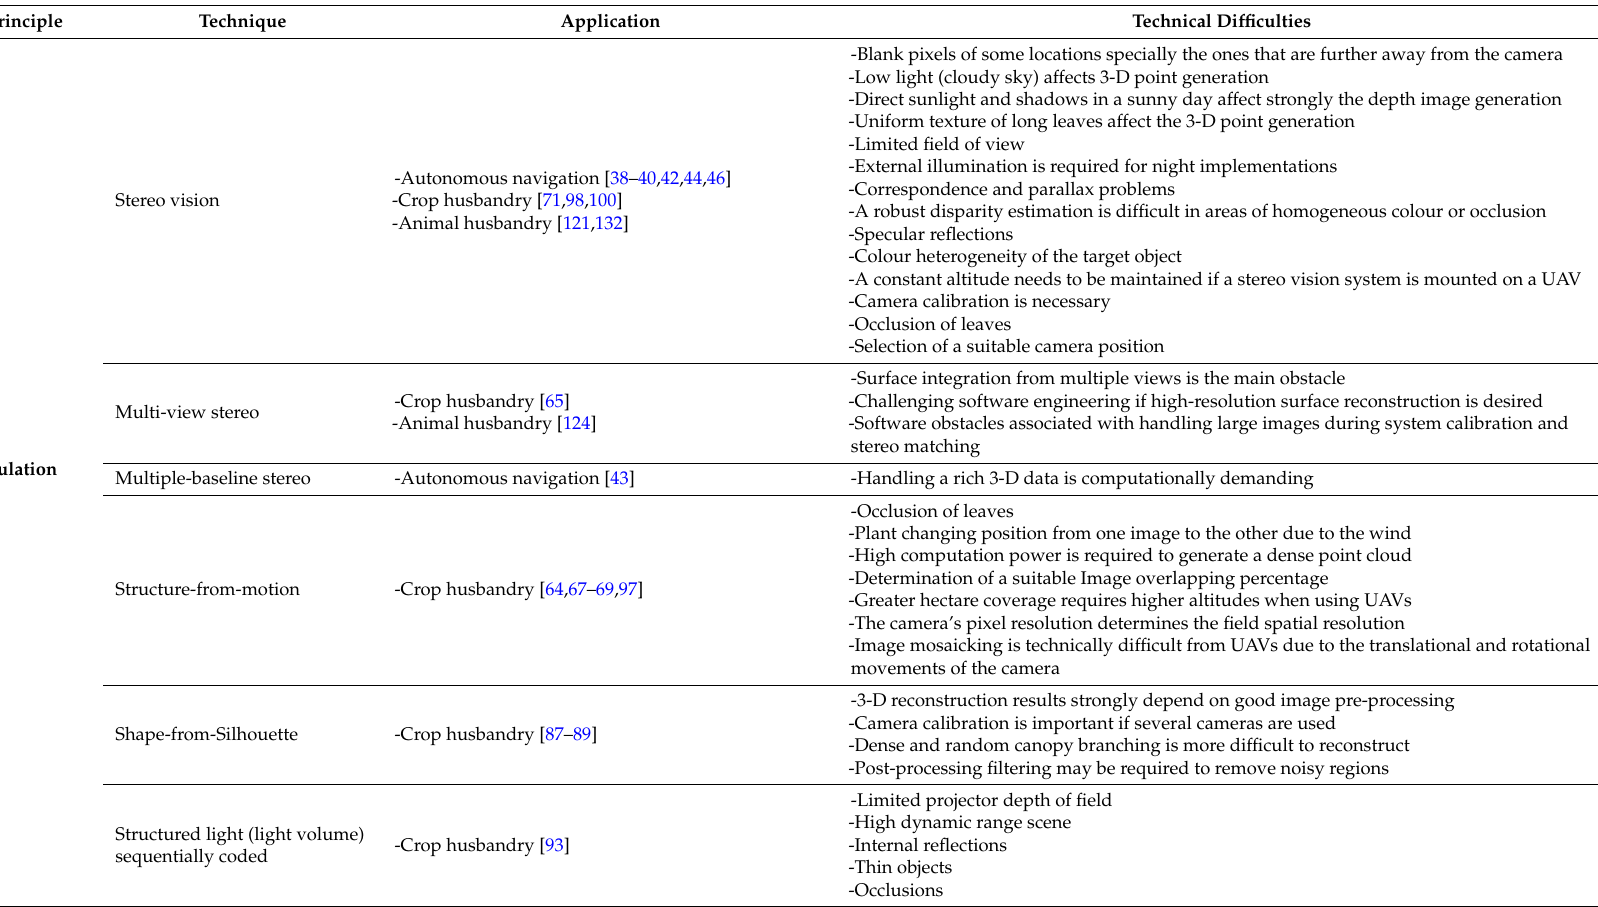
Table 4. Summary of the technical difficulties of the 3-D techniques used in agricultural